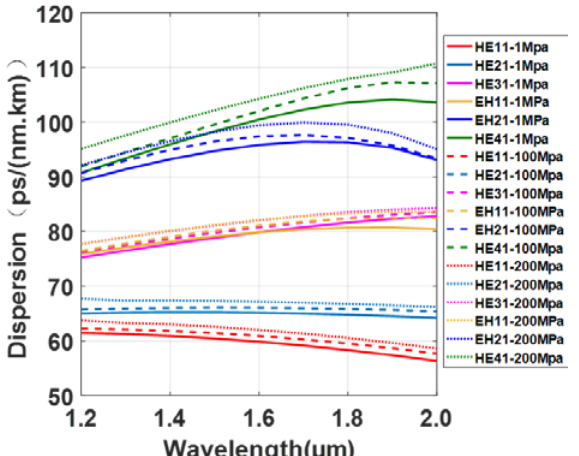
Figure 13. Dispersion as a function of wavelength for different modes.